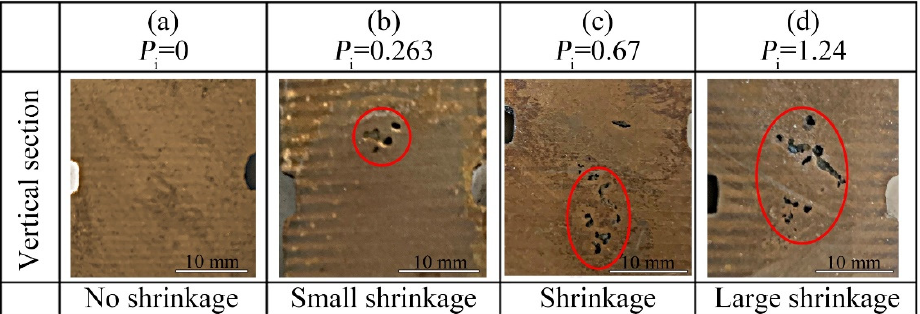
Figure 15. Relationship between P i and shrinkage tendency. ( a ) P i = 0; ( b ) P i = 0.263; ( c ) P i = 0.67; ( d ) P i = 1.24.